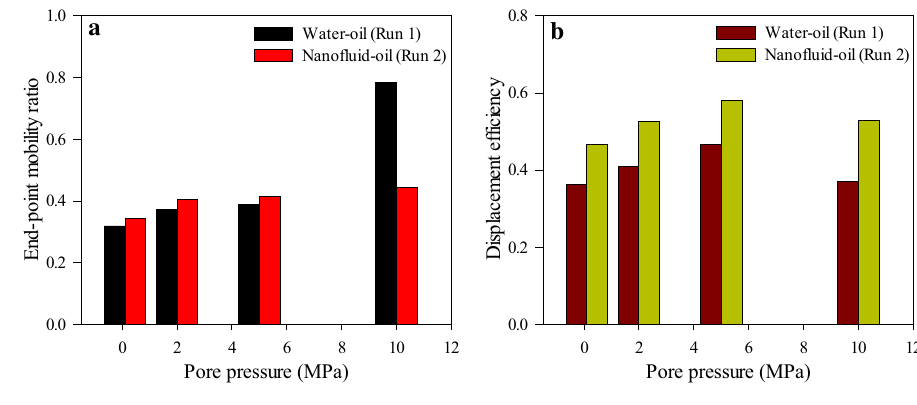
Fig. 13 Effect of pore pressure on a end-point mobility ratio and b displacement